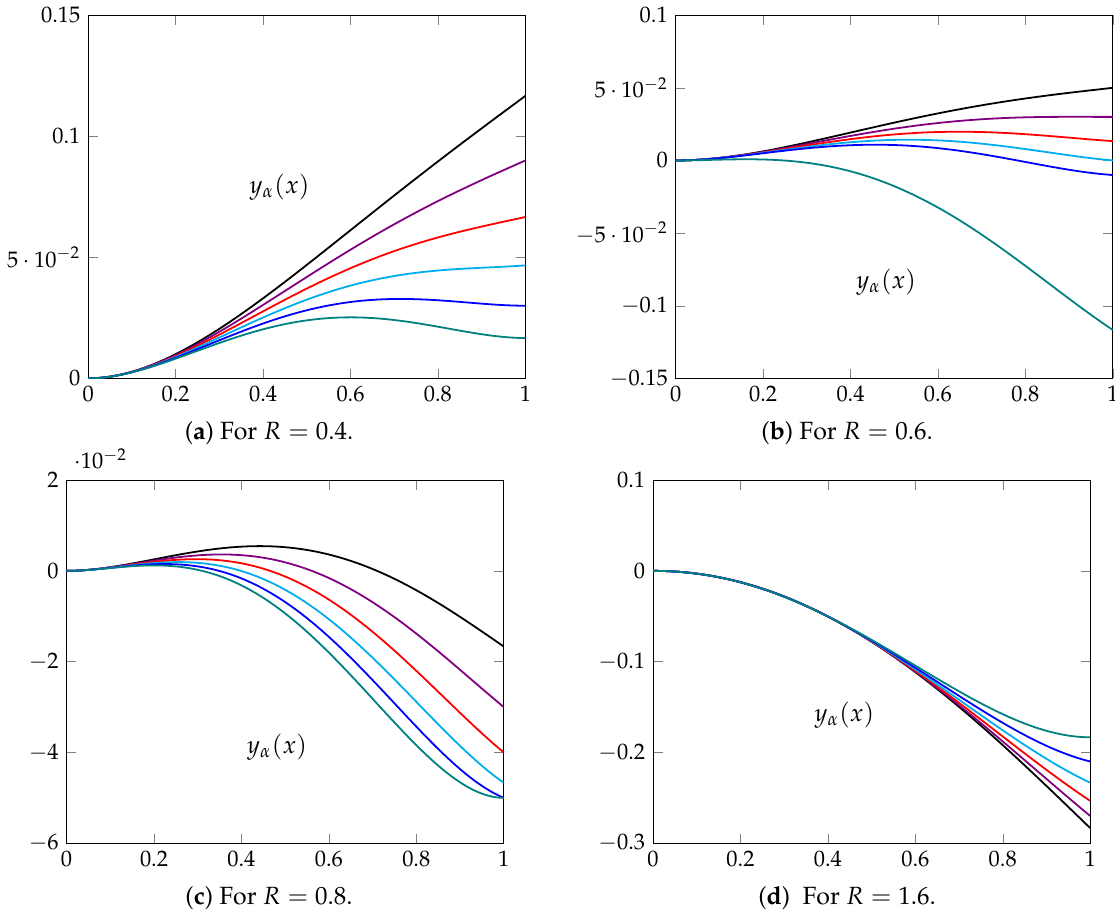
Figure 10. Graph of y α ( x ) given in (21) for α = 0, 0.2, 0.4, 0.6, 0.8,